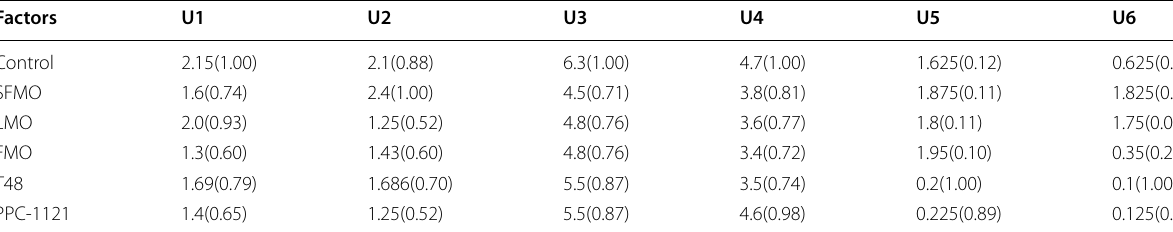
Table 5 Original experimental data and corresponding standardized data